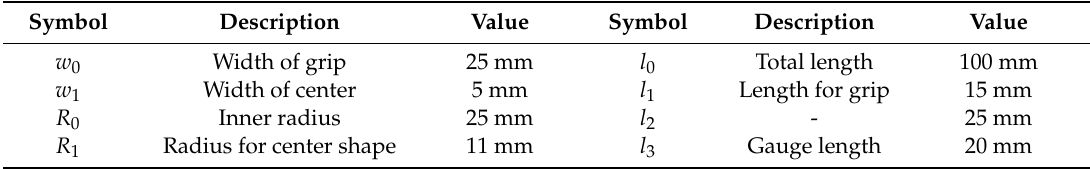
Figure 1. Schematic of the KS M 6518 tensile specimen. Table 1. Specimen details.